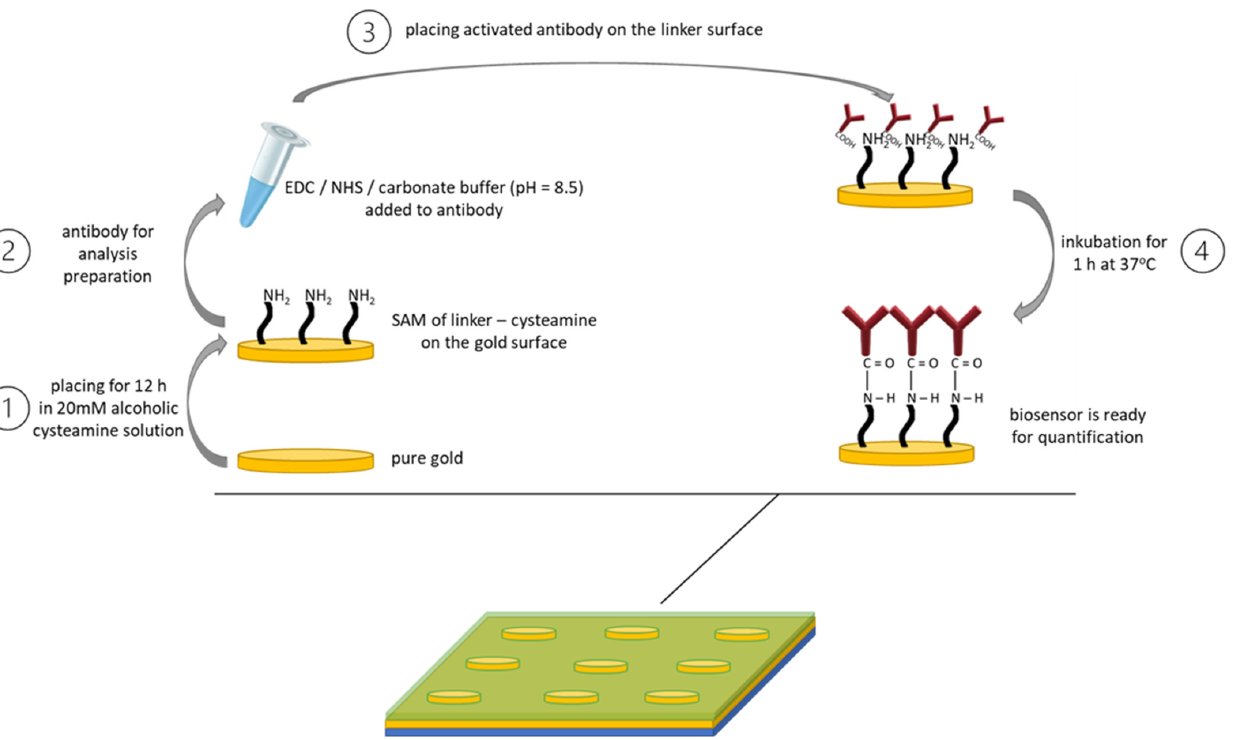
Figure 1. Scheme and conditions of linker (cysteamine) and ligand (monoclonal antibody) immobi- lization.